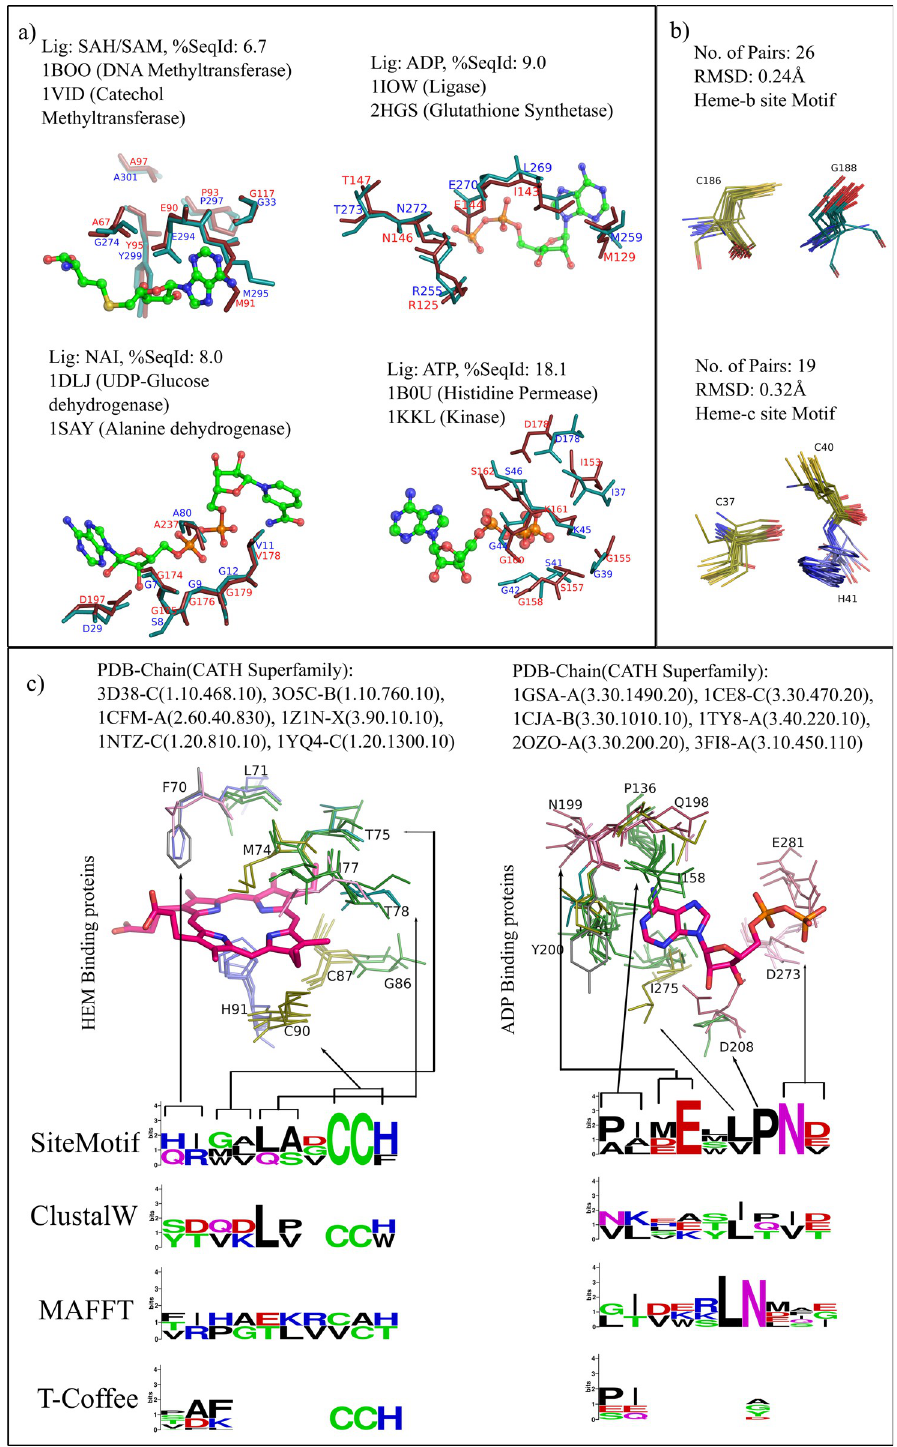
Fig 4. SiteMotif output of Site similarity in the pockets of proteins belonging to diverse folds. A) Pairwise comparison was carried out for four pairs of proteins that recognize the same ligand but have very low sequence similarities (value of percentage sequence identity (%SeqId) is shown for each pair). B) Test for accuracy of multiple alignments using two protein sets, one complexed with heme b ligand and the other complexed with heme c. The motif CXG was identified to be conserved for heme b binding proteins, whereas motif CXXCH was conserved in the sites